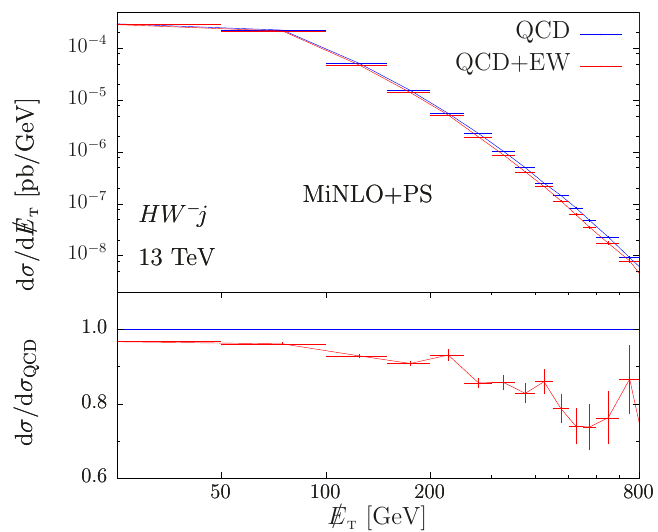
Figure 21. MiNLO +PS predictions for the missing transverse momentum in HW (cid:0) j production. Same curves and labels as in (cid:12)gure 20.